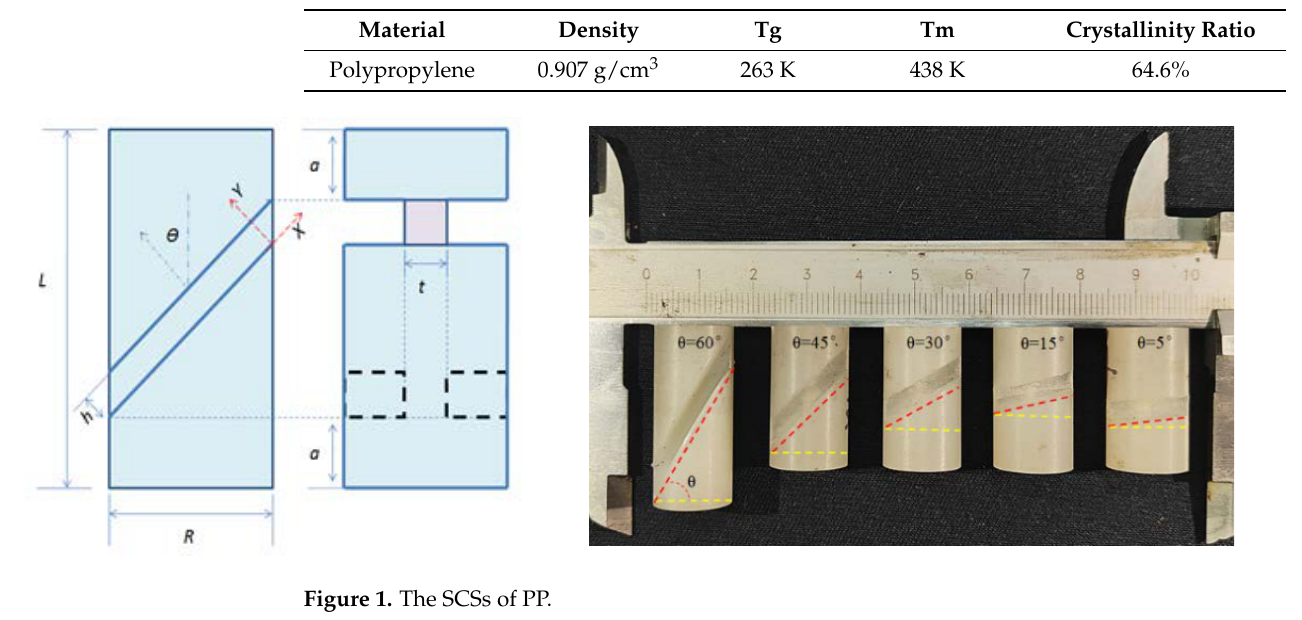
Table 1. Material parameters of polypropylene (from HuaSheng Rubber Co. Ltd.).